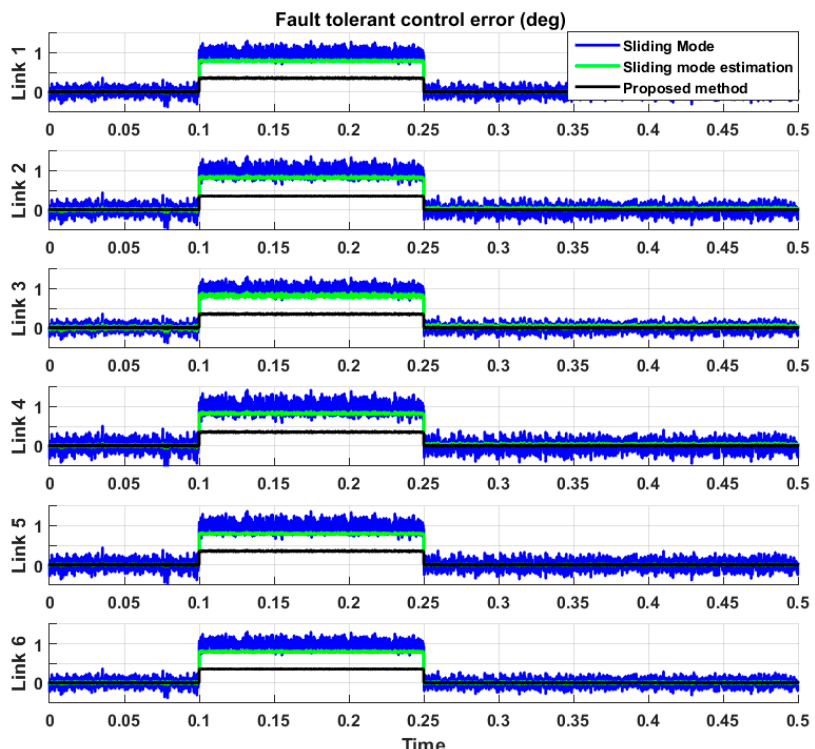
Figure 16. The power of fault-tolerant controllers in the faulty condition (proposed algorithm, sliding mode estimation technique, and classical sliding mode method).